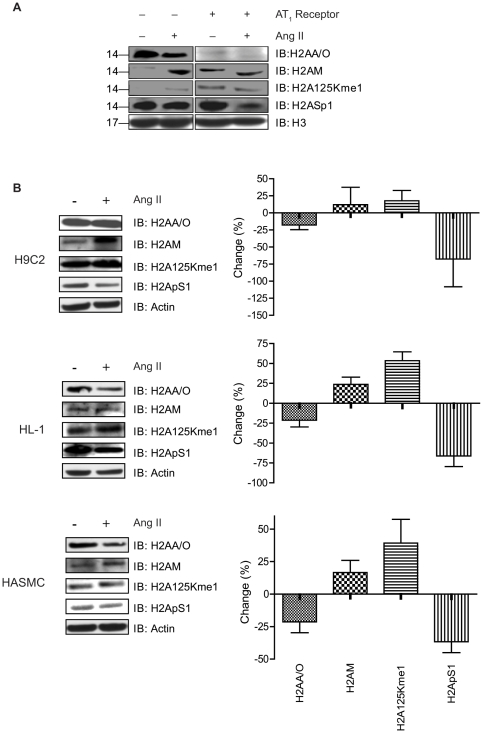
Immunochemical confirmation of isoforms and PTM of histone H2A.(A) Western blot analysis of nuclear extracts from HEK and HEK-AT1R cells treated with 1µM AngII for 1 hr using specified antibodies: H2AA/H2AO; H2A125Kme1; H2AM/H2A 25P hydroxyl; H4/H2A1Sp. The signal from H2AM/H2AP25hydroxyl antibody is indicative of H2AM, because we did not find hydroxyl-Pro in our MS analysis. The Ser-1p antibody signal is H2A-specific since we excluded H4 in the samples. Histone H3 Western blot was used as a loading control. (B) Western blot analysis of nuclear extracts from H9C2, HL-1 and HASMC cell lines treated with 1µM AngII for 5 hr using specified antibodies. Actin Western blot was used as a loading control. Band intensity values were obtained in three independent experiments. The right hand panels in 4B, shows mean ± SEM values for change compared to sample without AngII treatment.